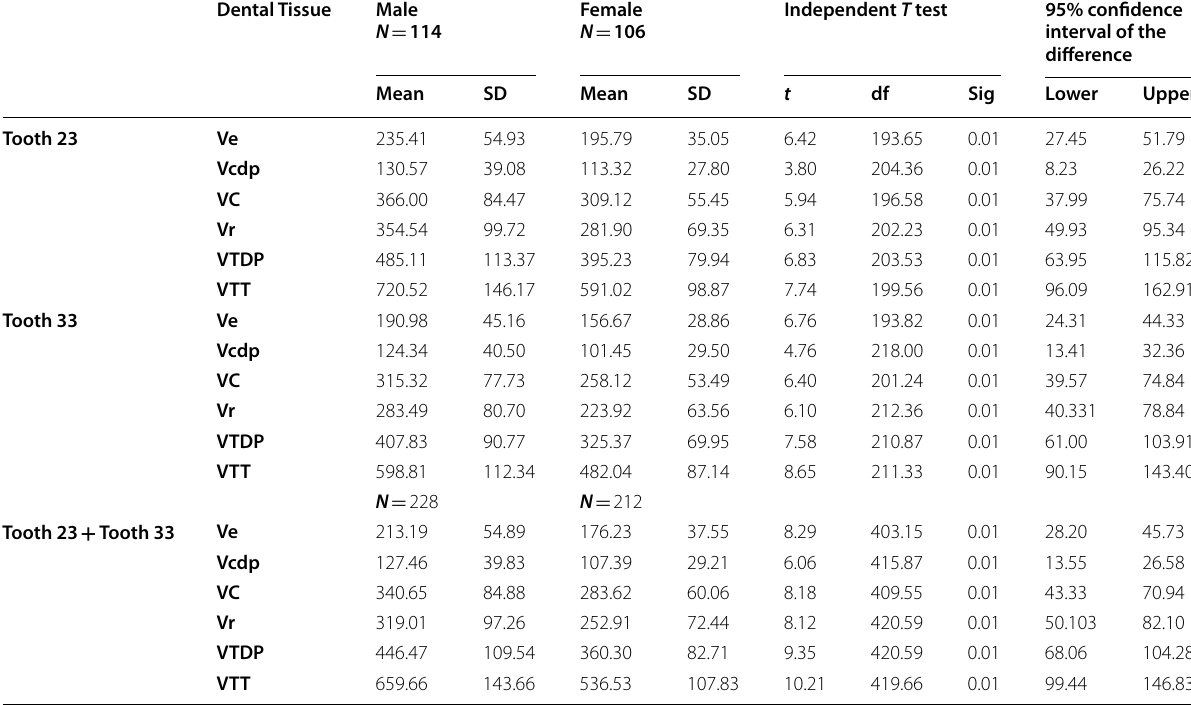
Note : N number of samples, combination, SD standard deviation, t computed test statistic, df degree of freedom, Sig p value, Ve volume of enamel, Vcdp volume of + coronal dentine and pulp, VC total crown volume, Vr volume of root, VTDP total dentine and pulp volume, VTT total tooth